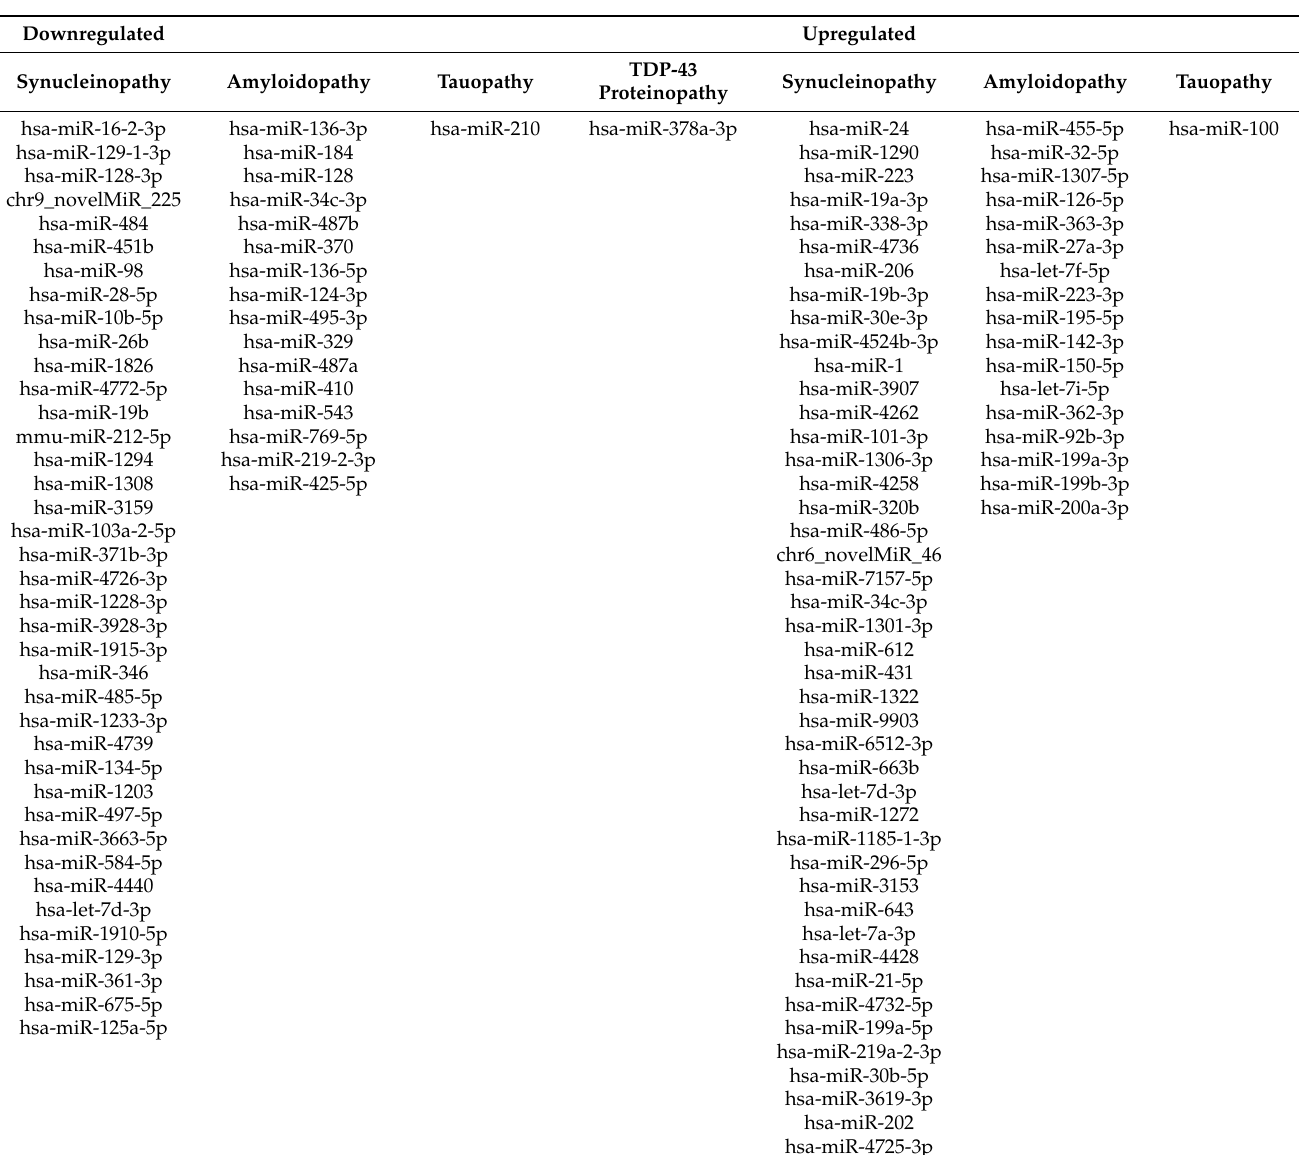
Table 3. List of consistently differentially expressed miRNAs post RRA in Synucleinopathies, Amy- loidopathies, Tauopathies and TDP-43